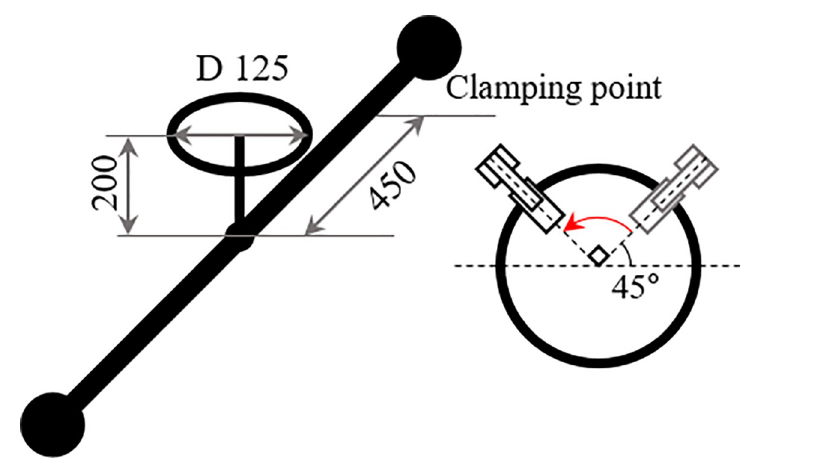
Fig 5. Manipulator control